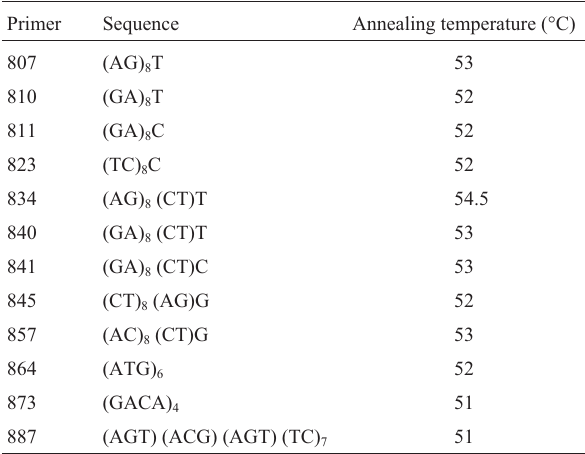
Table 1 - Primers used for ISSR amplification.